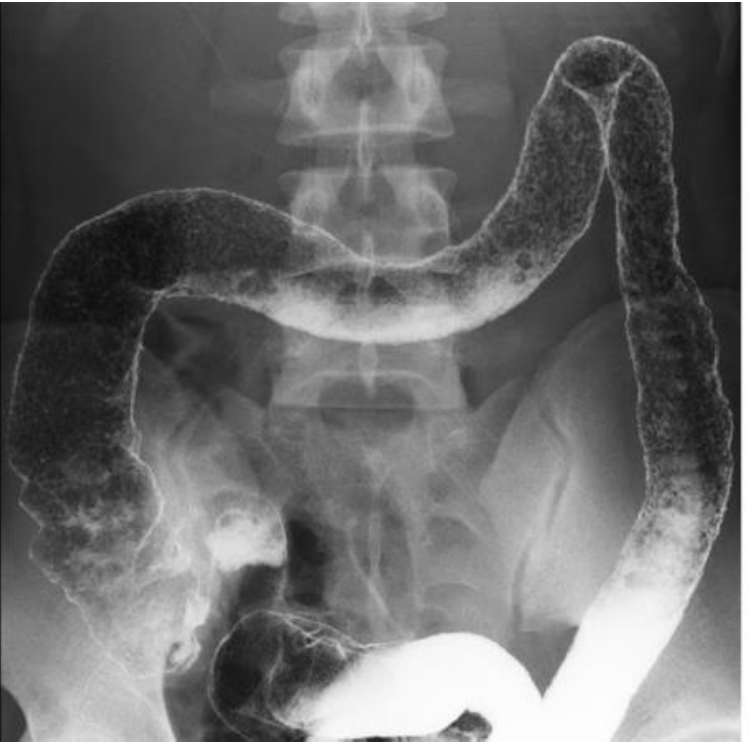
Figure 5. Roentgenogram of a double-contrast barium enema study on the 23rd hospital day. Coarse mucosa, irregular border, shortening of the bowel, and loss of haustration in the right and transverse colon were observed. It indicated active pancolitis.